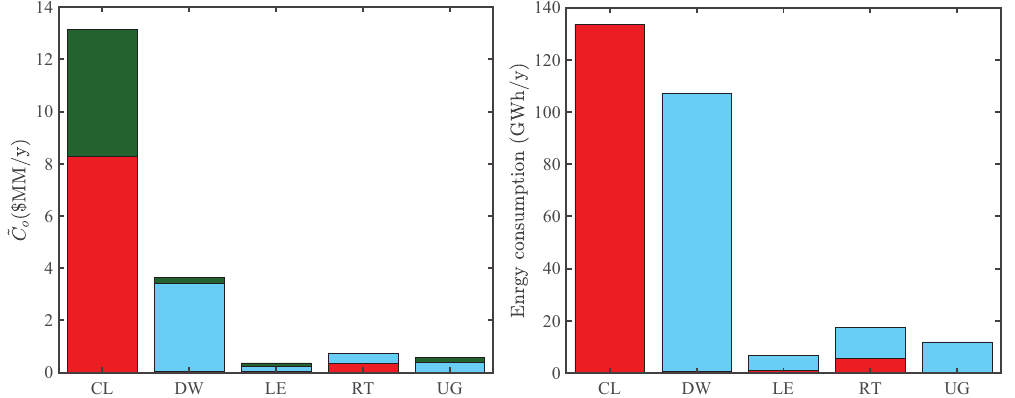
Figure 6. Comparison of annual operating costs and energy consumption of the cultivation (CL), harvesting and dewatering (DW), lipid extraction (LE), upgrading (UG), and remnant treatment (RT) processing sections in Optimization Strategy I. Left panel: components of the reduced annual operating cost, including material (green), power (red), and heat (blue) costs. Right panel: power (red) and heat (blue)